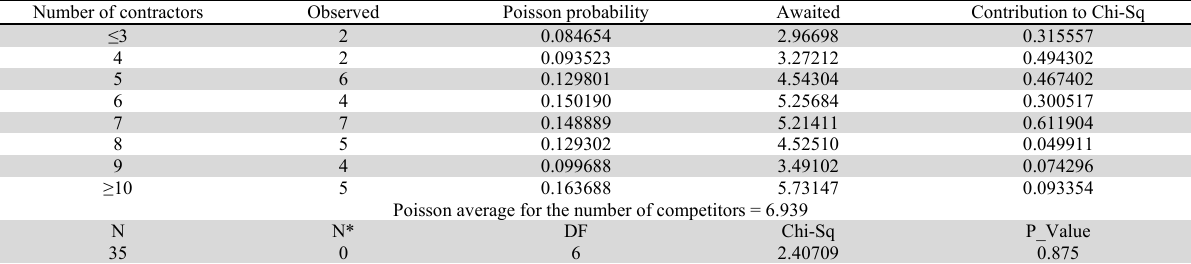
Outcome of the Chi-squared fitting test for the number of competitors. Number of contractors